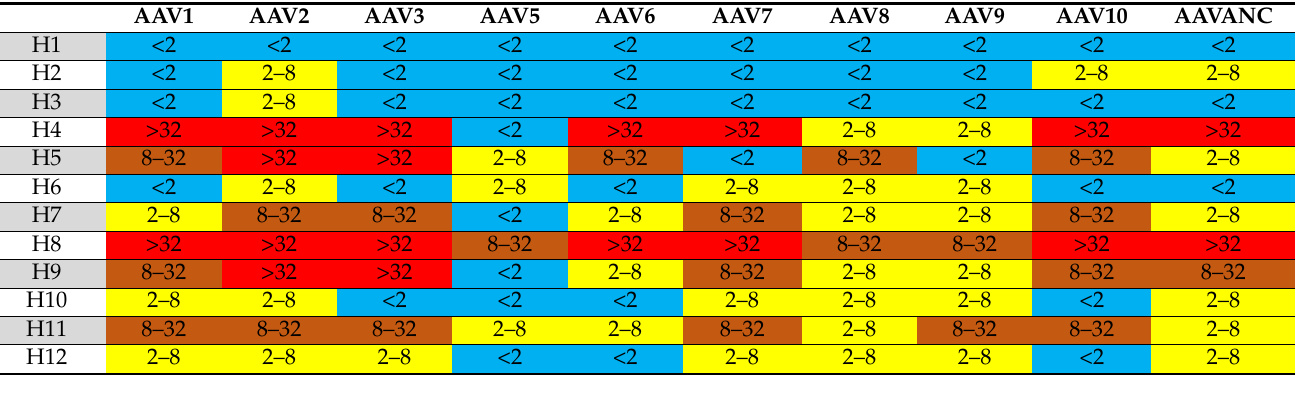
Table 1. Summary of the AAV NAB profile for each individual patient. Blue, yellow, brown, and red correspond to AAV NAB titers ≤ 2, 2–8, 8–32, and ≥ 32,